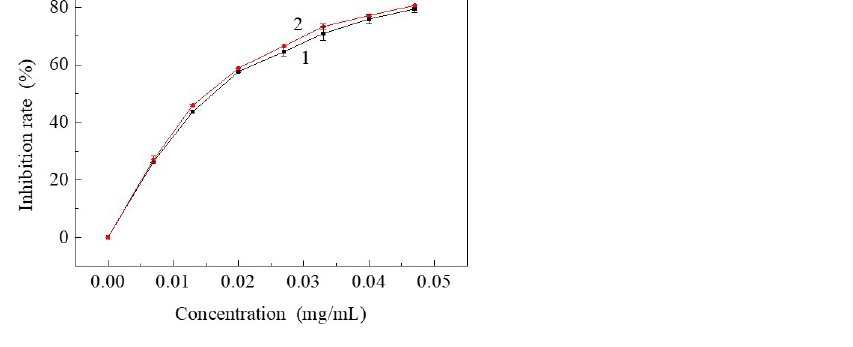
Figure 6. The inhibiting rate of resveratrol to DPPH: (1) Untreated resveratrol; (2) Resveratrol ◦ C, 20 MPa, 90 treated by SCF-CO 2 at 80 °C, 20 MPa, 90 min. by SCF-CO 2 at 80